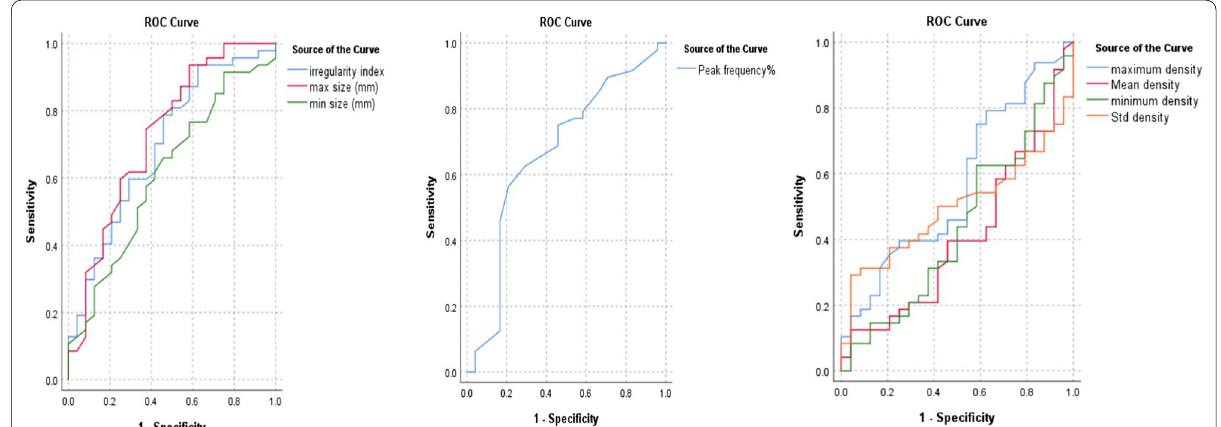
Fig. 1 ROC curve for the detection of malignancy using size, short‑ and long‑axis diameters, irregularity index (left curve), peak frequency percentage (middle curve), and density (right